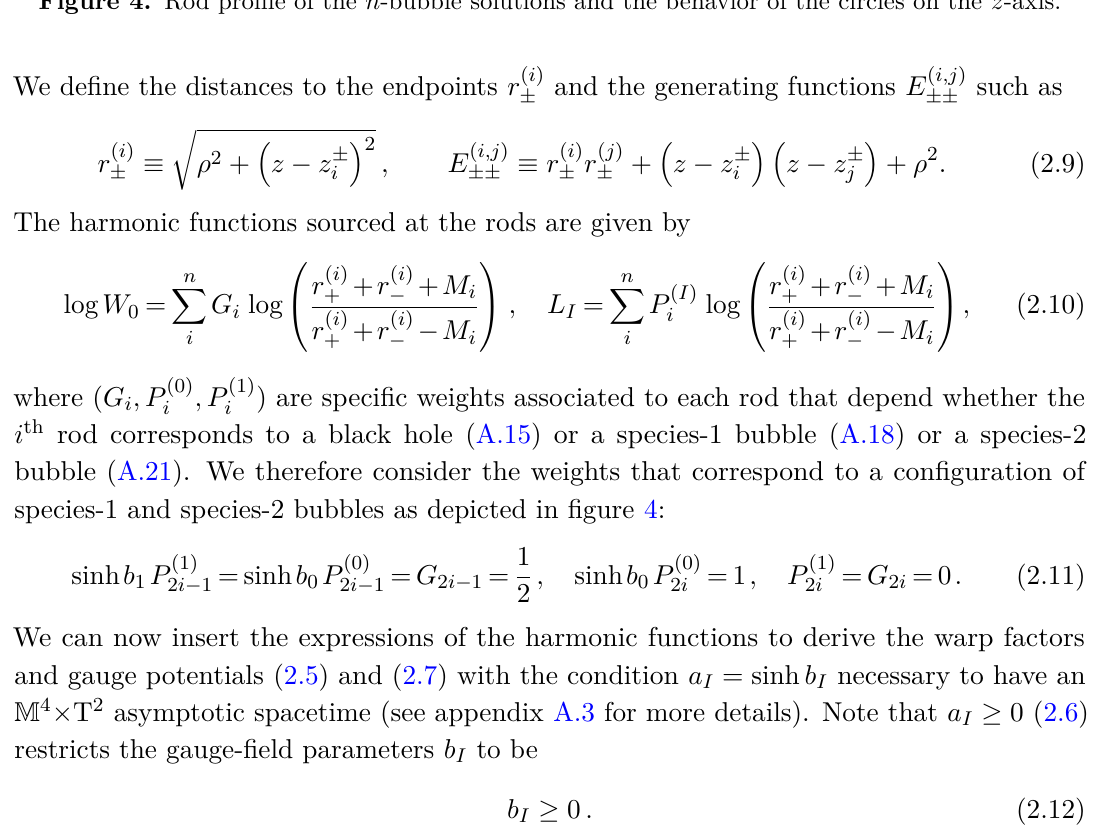
Figure 4. Rod profile of the n -bubble solutions and the behavior of the circles on the z